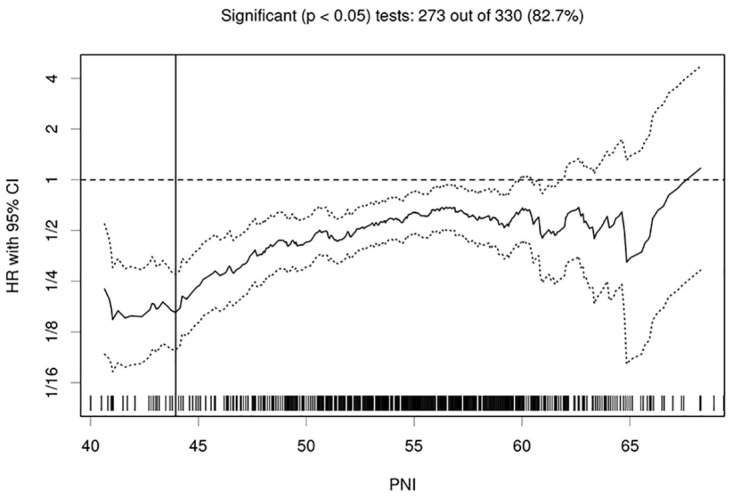
Hazard ratio (HR) for distant metastasis-free survival (DMFS) independent of the cutoff point for prognostic nutritional index (PNI) in patients with nasopharyngeal carcinoma.The vertical line designates the optimal cutoff points with the most significant split (log-rank test). The plots were generated using Cutoff Finder.